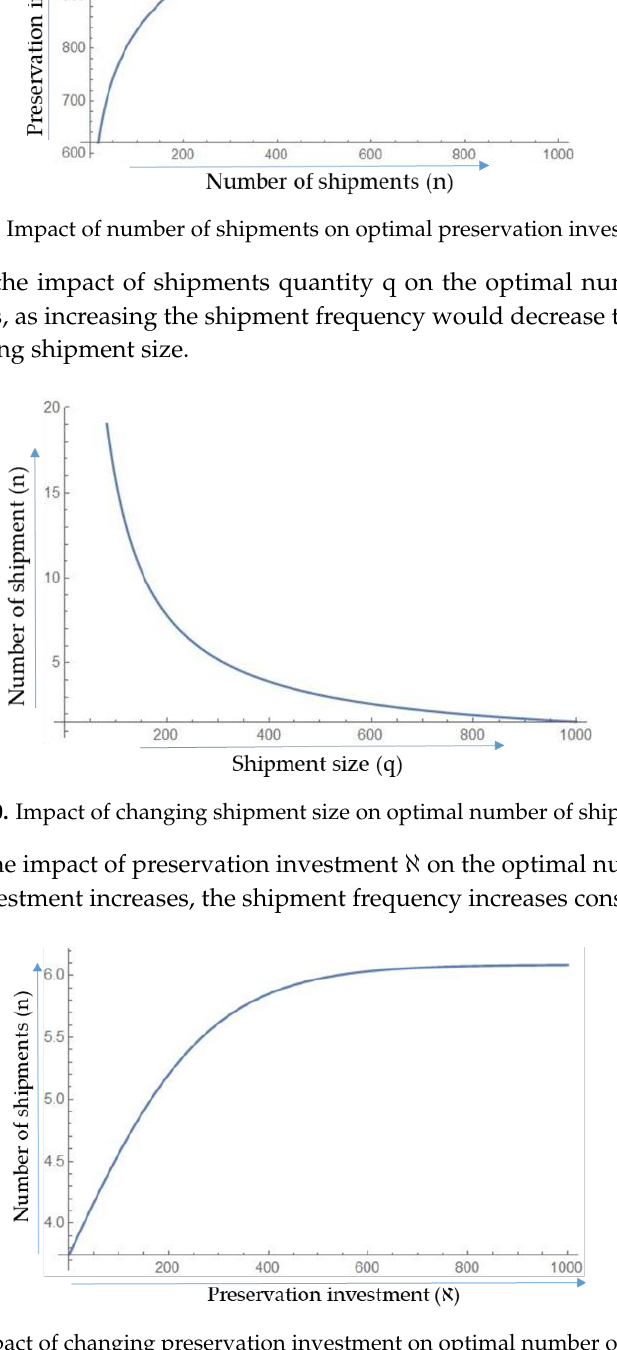
Figure 11. Impact of changing preservation investment on optimal number of shipments.